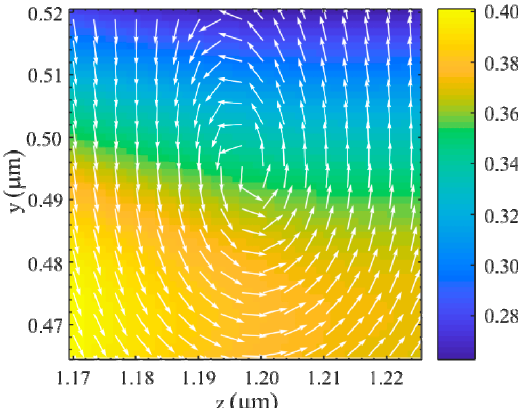
Figure 5. Intensity distribution (color) and directions of the Poynting vectors (arrows) in the region of the toroidal vortex that rotates counterclockwise and is nearest to the r - and z -axes (area 2 in Figure 3a).